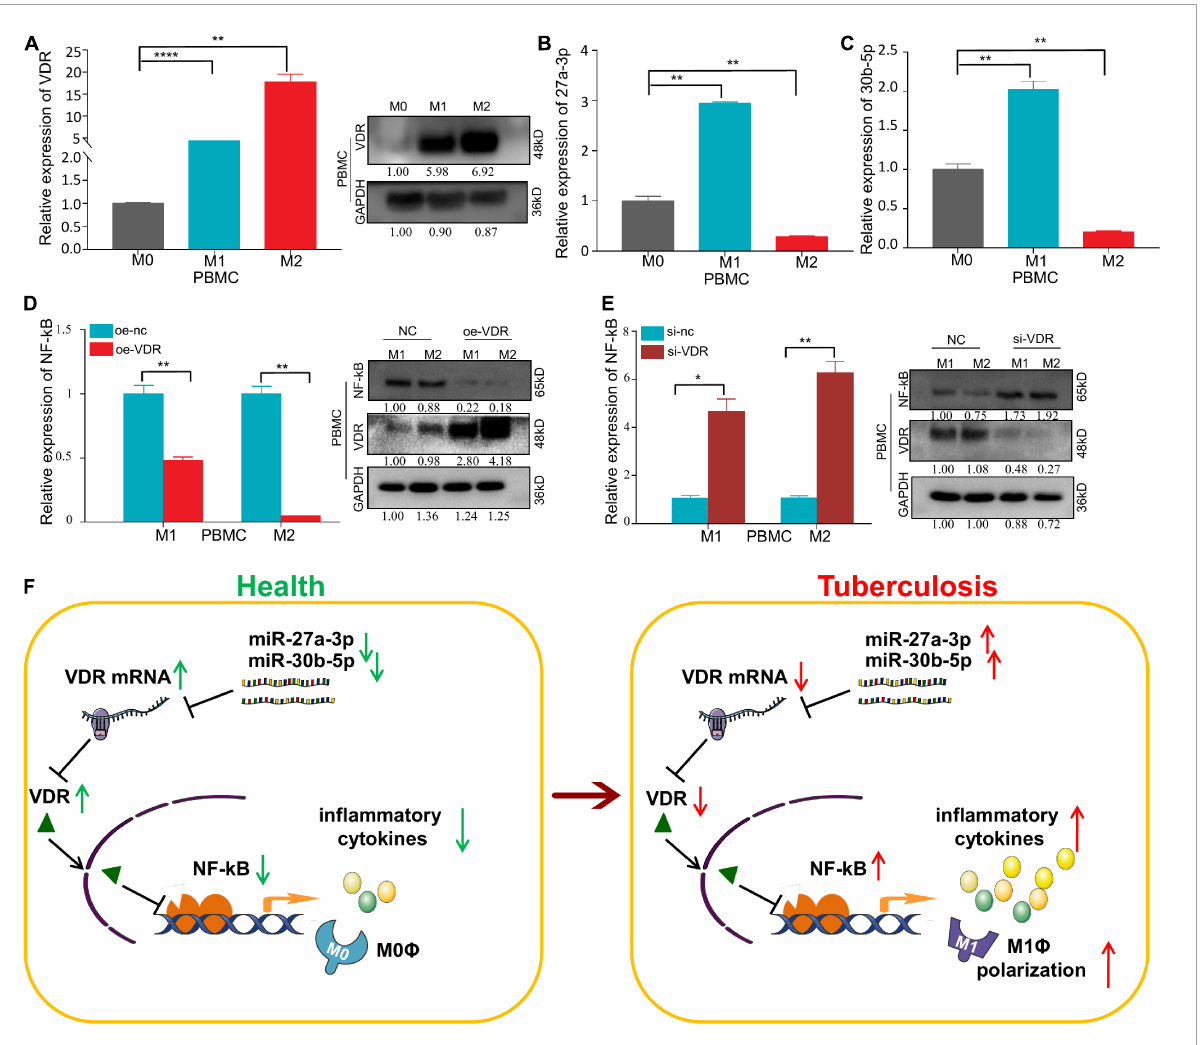
FIGURE7 An opposite trend of VDR and miRNA expression has been observed and VDR can inhibit the expression of NF-kB p65 in macrophages. (A) The relative expression of VDR in PBMC–derived M0, M1, and M2 macrophages significantly increased successively, as determined by qRT–PCR and Western blot assay. (B) The relative expression of miR-27a-3p in PBMC-derived M0, M1, and M2 macrophages. Compared with M0 macrophages, the relative expression of miR-27a-3p in M1 macrophages was significantly increased, but it was significantly decreased in M2 macrophages. (C) Compared with M0 macrophages, the relative expression of miR-30b-5p in M1 macrophages was also significantly increased, but it also significantly decreased in M2 macrophages. (D) After overexpression of VDR in PBMC-derived M1 and M2 macrophages, the expression of NF-kB p65 was measured by qRT–PCR and Western blot assay. Compared with the control group, the expression of NF-kB p65 was significantly decreased in M1 and M2 macrophages, which was opposite to the VDR expression trend. (E) After knocking down VDR expression in PBMC-derived M1 and M2 macrophages, the expression of NF-kB p65 was measured by qRT–PCR and Western blot assay. Compared with the control group, the expression of NF-kB p65 was significantly increased in M1 and M2 macrophages, which was